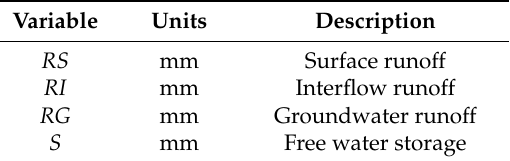
Table 2. Descriptions of the